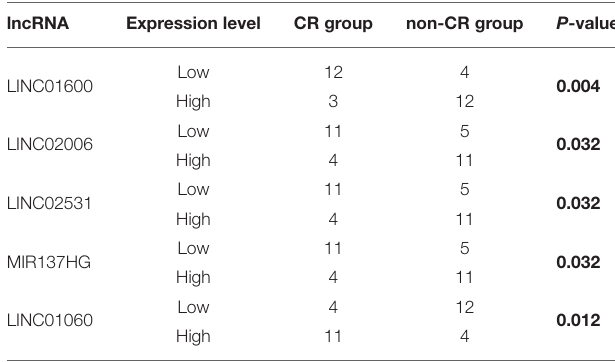
TABLE 1 | Chi-square test between lncRNA expression and